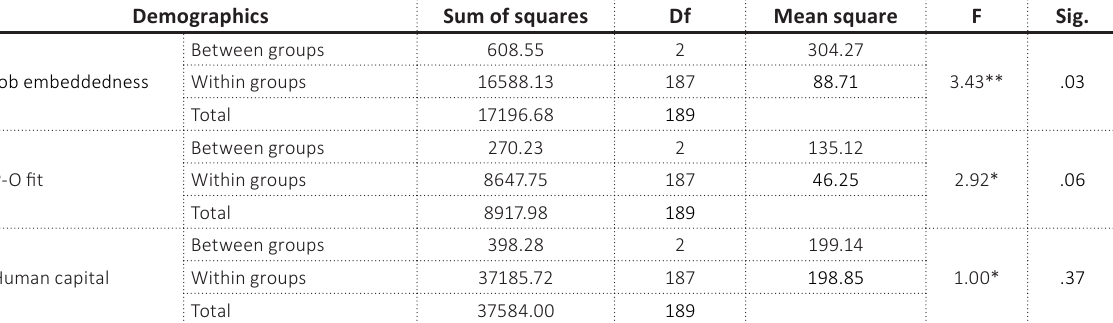
Table 10. Data and ANOVA based on qualification Demographics Sum of squares Df Mean square F